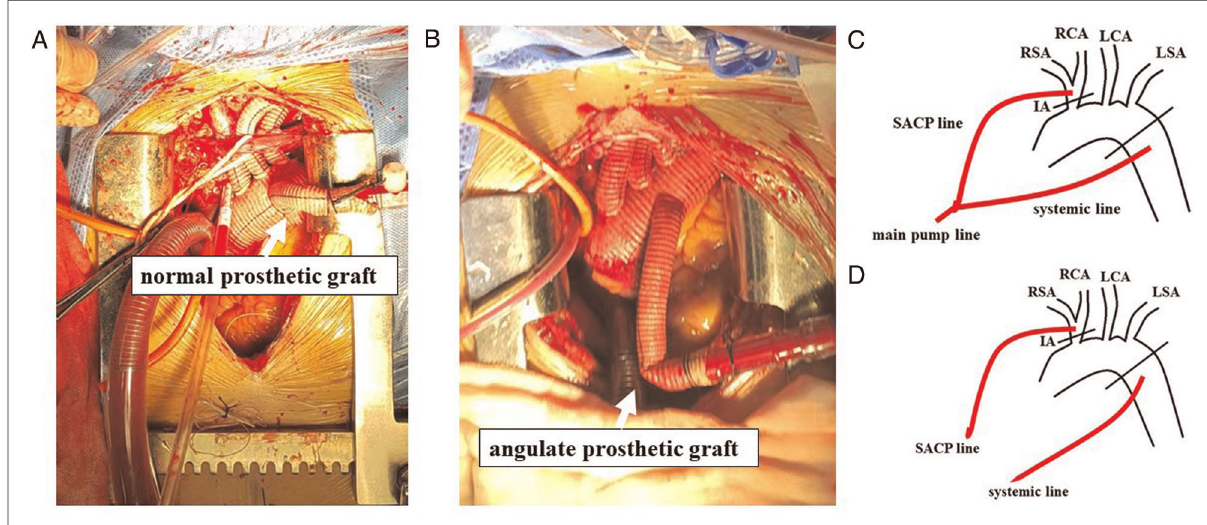
FIGURE 3 Angulated prosthetic graft and the advance of pump-controlled SACP. ( A ) A normal prosthetic graft for systemic (lower body) perfusion. ( B ) An angulated prosthetic graft for systemic (lower body) perfusion. ( C ) The main pump line split to the SACP line and the systemic line in the Control group. With the constant fl ow of the main pump, the decreased systemic fl ow caused by the angulated prosthetic graft increased SACP fl ow. ( D ) The main pump controlled the fl ow of the systemic line, while the cardioplegia pump controlled the fl ow of the SACP line. The angulated prosthetic graft in fl uenced only the fl ow of the systemic line. The fl ow of the SACP line was always modulated accurately. SACP, selective antegrade cerebral perfusion; IA, innominate artery; RSA, right subclavian artery; RCA, right common carotid artery; LCA, left common carotid artery; LSA, left subclavian